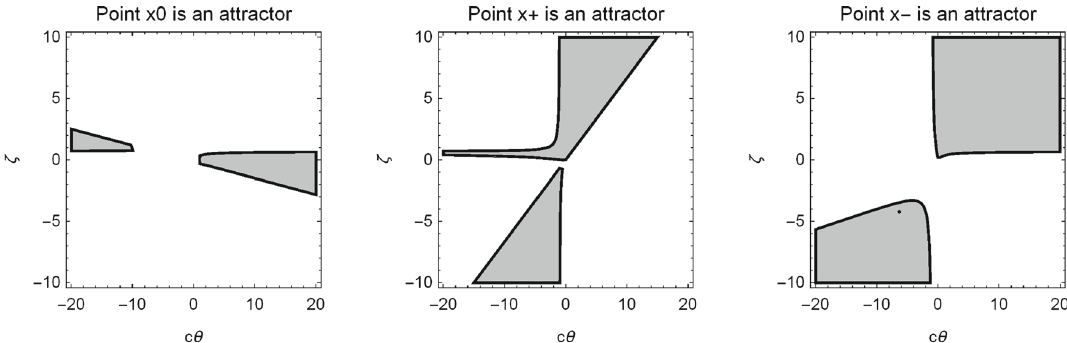
Fig. 3 Region plots in the space of parameters { c θ ,ζ } , where the stationary points: x 0 (left fig.), x + (middle Fig.) and x − (right fig.) are attractors for the cosmological model with a dust fluid source